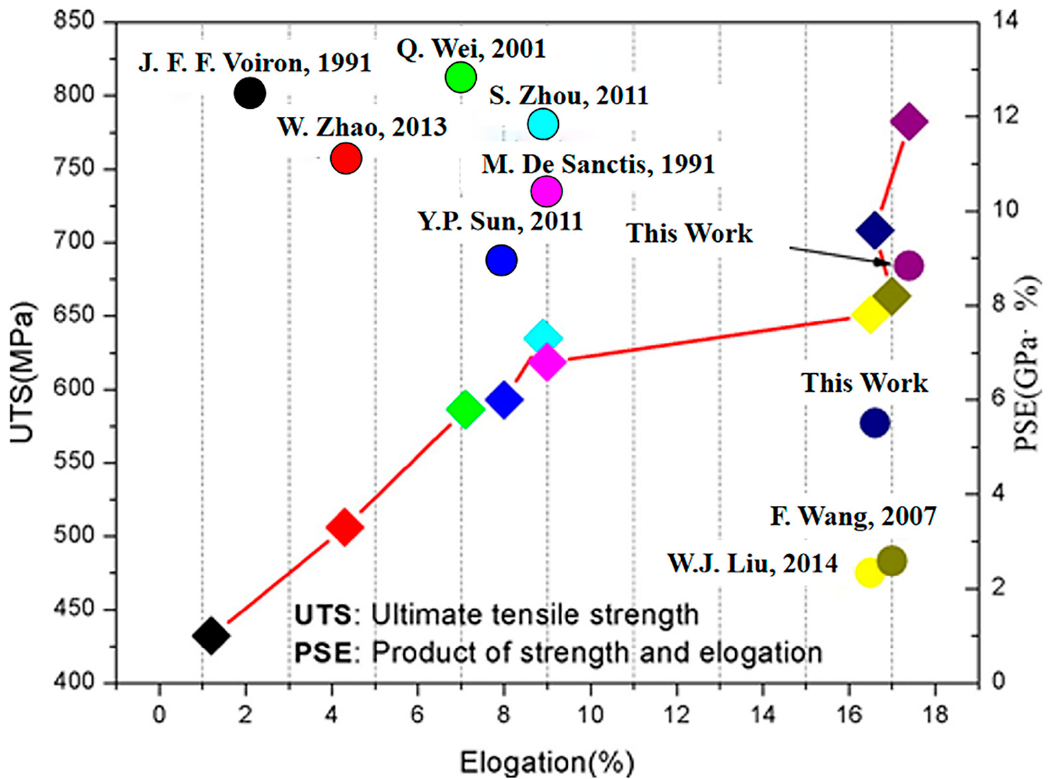
Figure 18. T he mechanical properties of different processing methods [92]. Figure 18. The mechanical properties of different processing methods